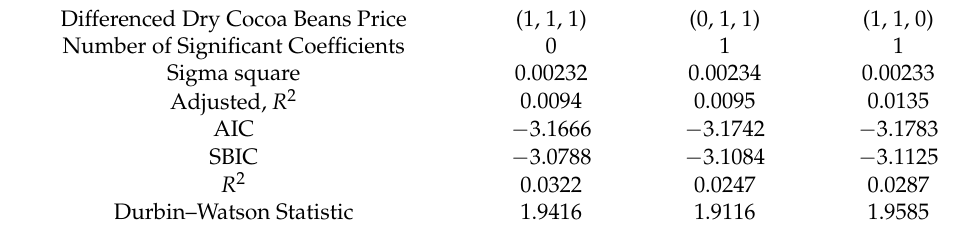
Table 5. Summary of ARIMA estimation output for differenced Dry Cocoa Beans Price.